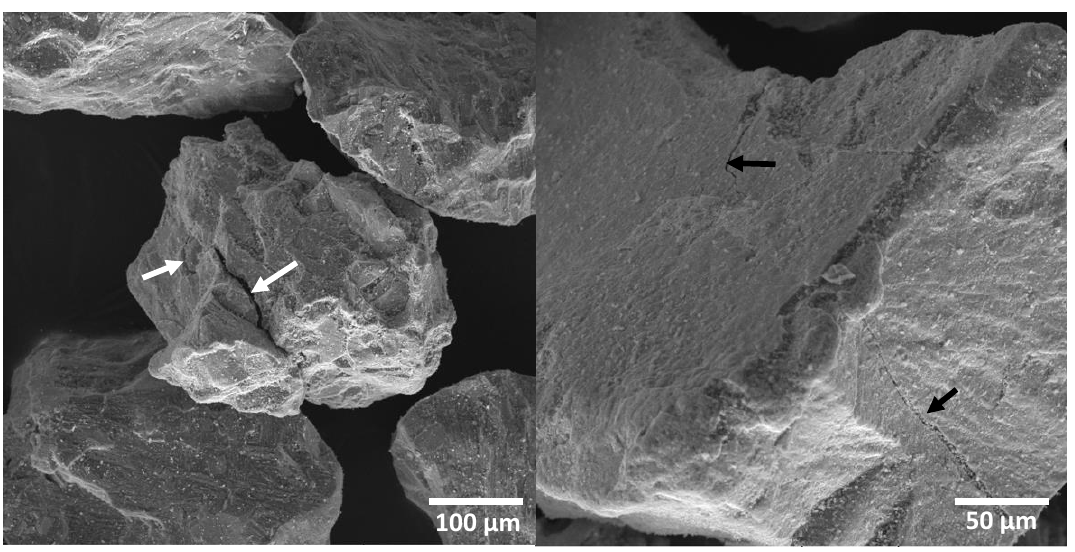
Figure 2. Scanning electron microscopy (SEM) micrograph of original sample of converter slags (264× and 546× magnification.